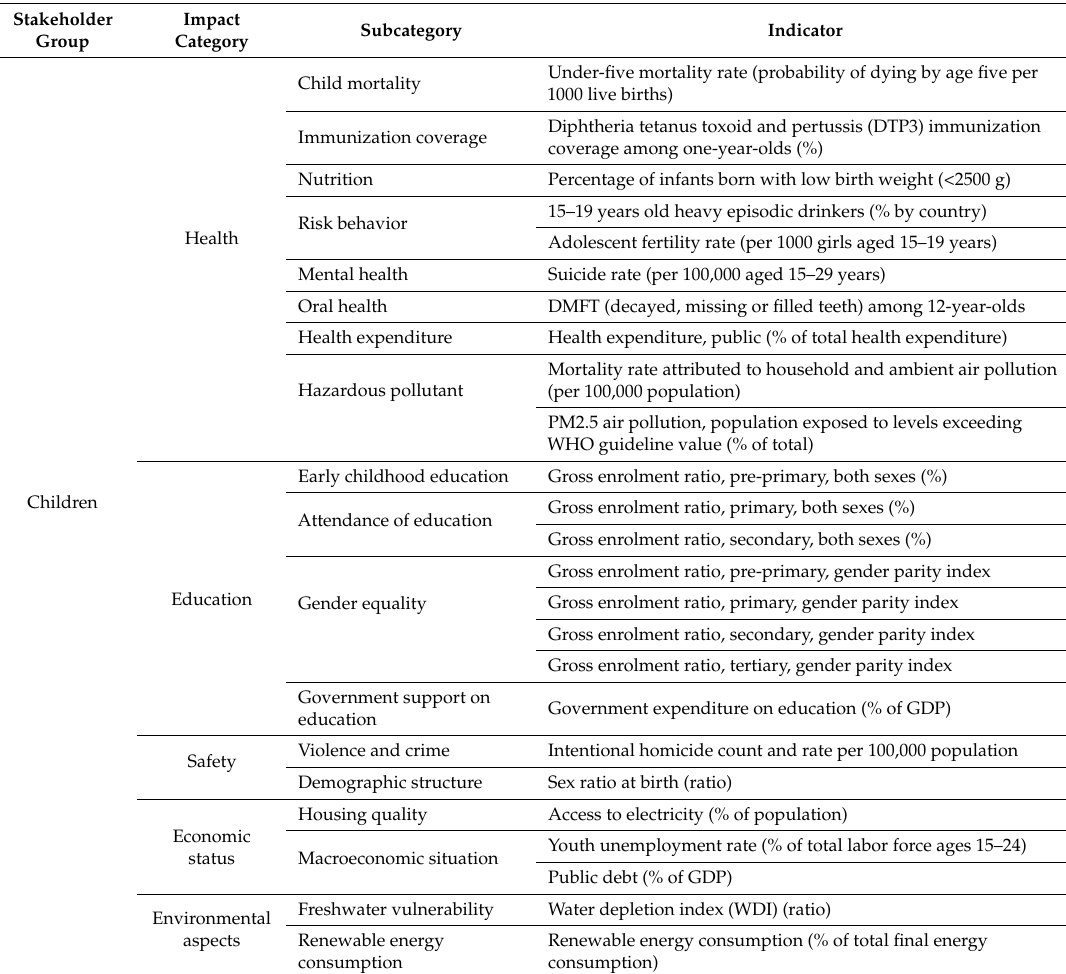
Table 2. Impact categories, subcategories and indicators for the proposed stakeholder group children, adapted from the current SCDI framework